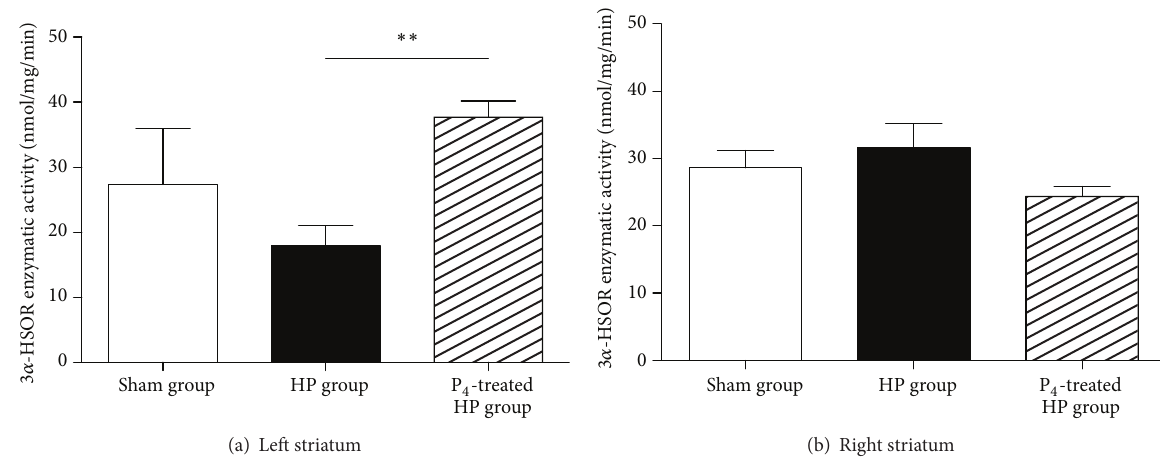
Figure 5: Enzymatic activity of 3 𝛼 -HSOR in left (a) and right (b) striatum of sham, HP, and P 4 -treated HP groups. Results are expressed as a mean ± SEM of nmol/mg/min; ∗∗ 𝑃 < 0.01 (one-way ANOVA). HP group (hemiparkinsonian group), P 4 -treated HP group (progesterone- treated hemiparkinsonian group).